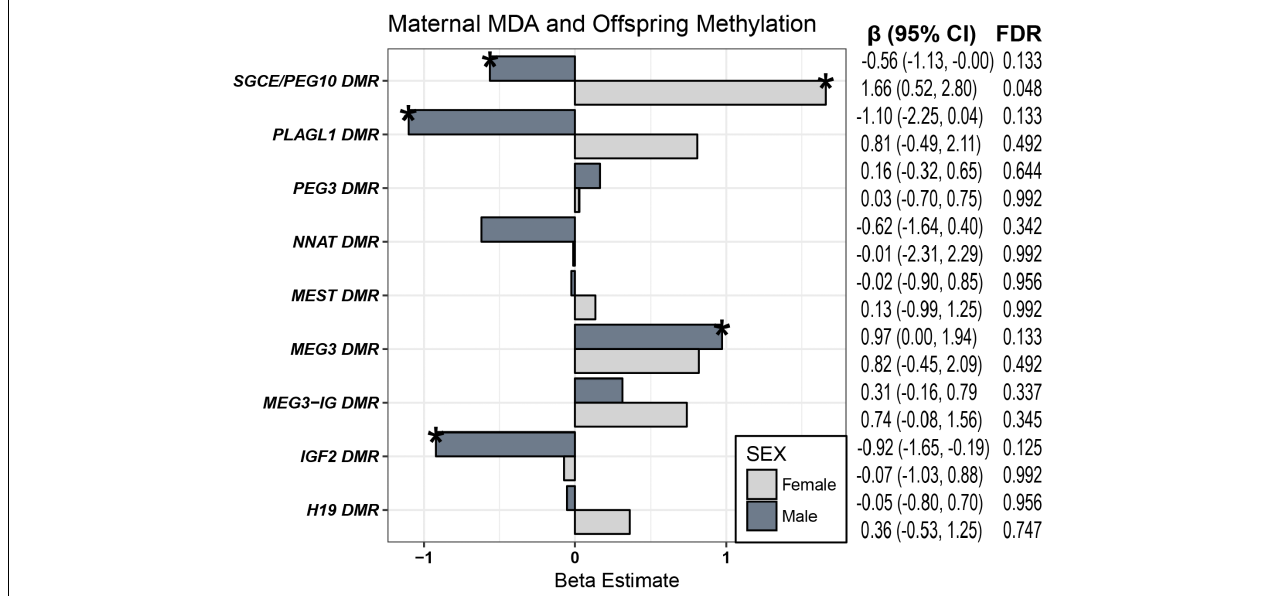
FIGURE 2 | Maternal MDA and CpG Methylation. Females (light gray) and males (dark gray) were evaluated separately with linear regression for associations of maternal MDA on the average methylation status of the control region of 9 imprinted gene loci. Effect estimates for mean CpG methylation were adjusted for breastfeeding at least 3 months, age of child at behavioral assessment, maternal fiber intake, total calories, folate, education, diabetes, obesity, smoking, and age, as well as paternal age and child parity, premature birth, weight, race ( ∗ FDR q < 0.15; n ranged from 51 to 75).